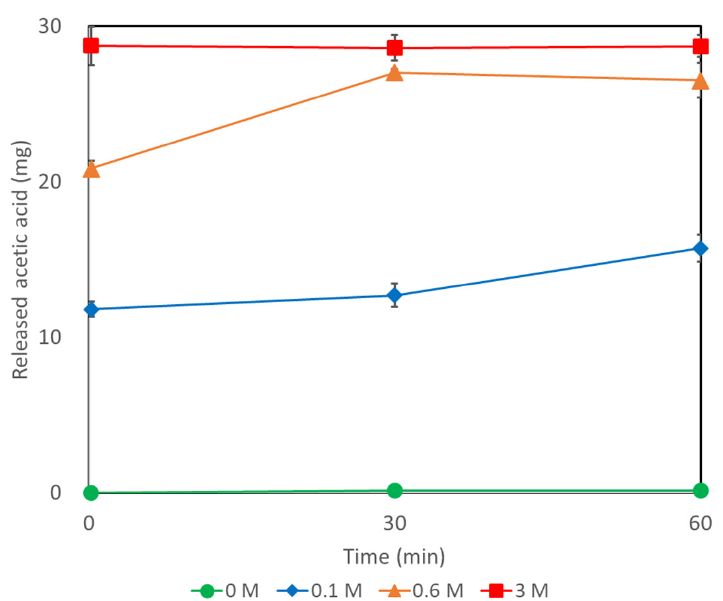
Figure 6. Desorption of the adsorbed acetic acid from AQ11 in NaCl solutions.